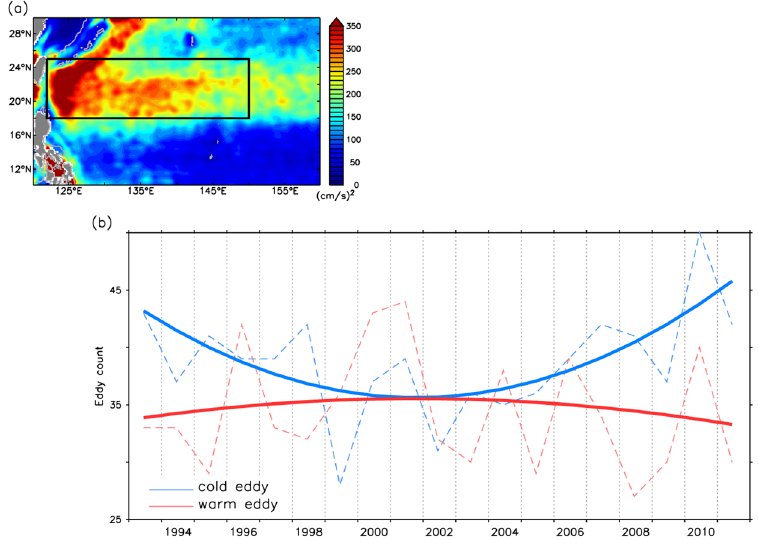
Figure 4. Eddy characteristics in the Subtropical Countercurrent region delineated by a black rectangle (122– 150°E and 18–25°N). ( a ) Annual mean of eddy kinetic energy during 1993–2013. ( b ) Yearly cold/warm eddy number. Dash line indicated the number of eddies. Solid line is for the last IMF. All figures are generated with FERRET (v6.93;